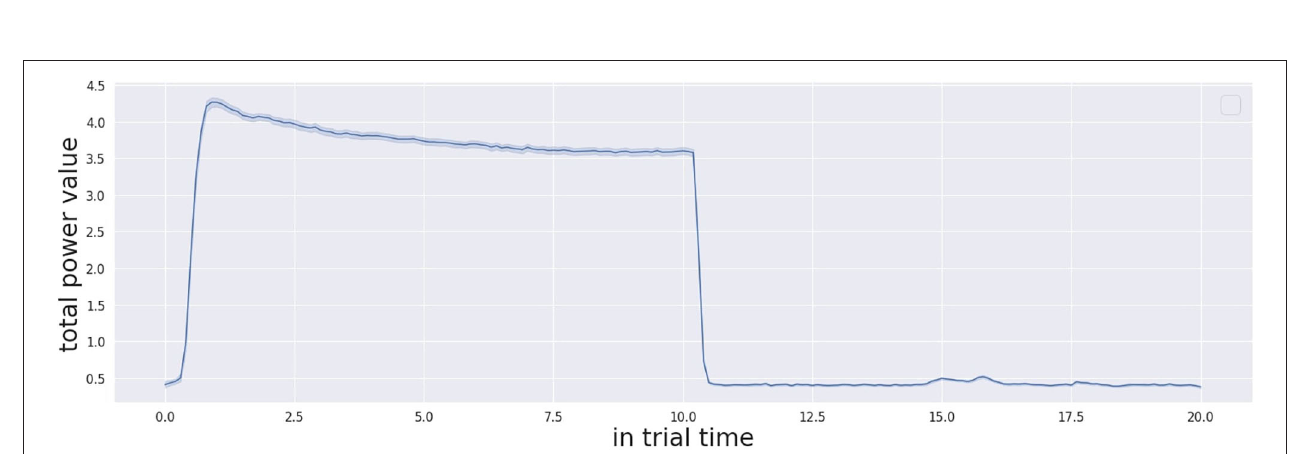
FIGURE 6 | Confidence profile (gamma measure Ŵ ) across the whole trial time (20 s) for both audio-visual and audio only trials.